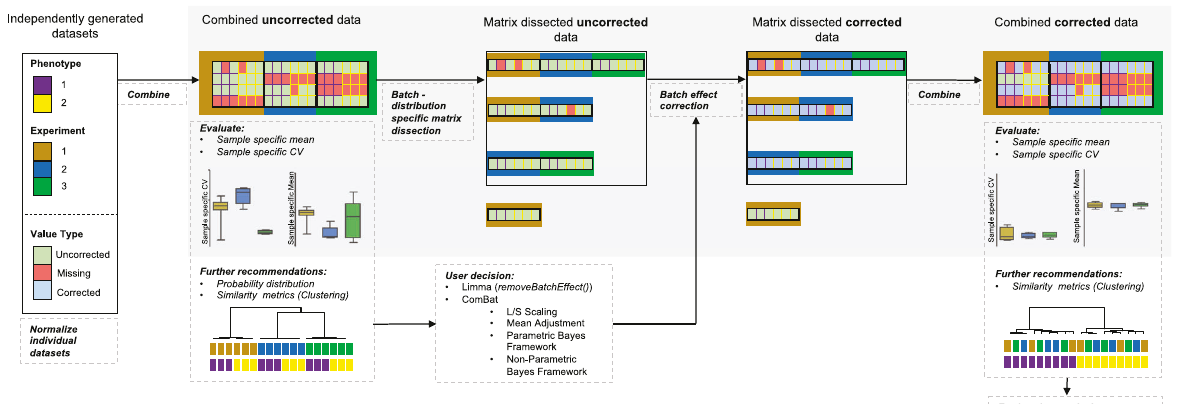
Fig. 1 The general HarmonizR operation principle. Schematic representation of the HarmonizR operation principle for batch effect reduction across independent proteomic